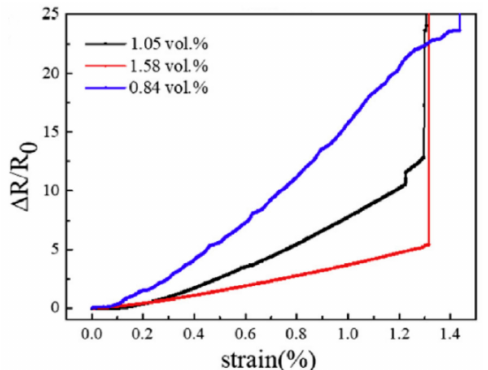
Figure 21. Response of GNP / epoxy nanocomposites to strain for di ff erent filler concentrations. Reproduced with permission from [123]. Copyright 2018, Elsevier.